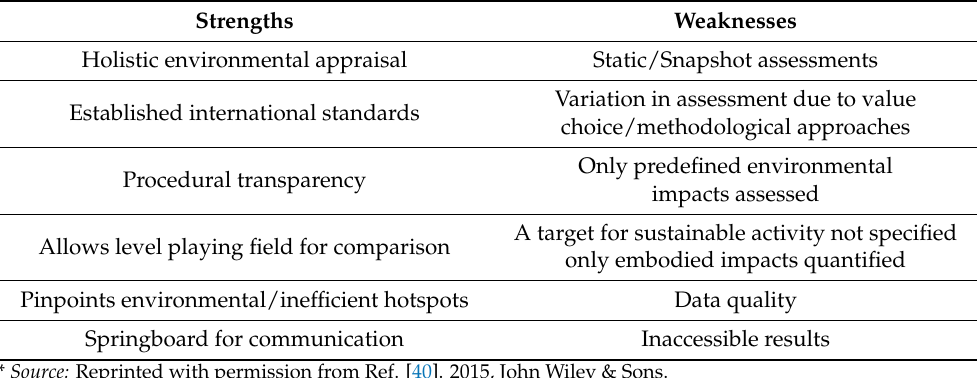
Figure 6. The four main stages of environmental LCA. Source: Allen et al. [21]; adapted from the ISO [71]. Reprinted with permission from Ref. [21]. 2020, KeAi Communications. Table 1. Overview of strengths and weaknesses of LCA